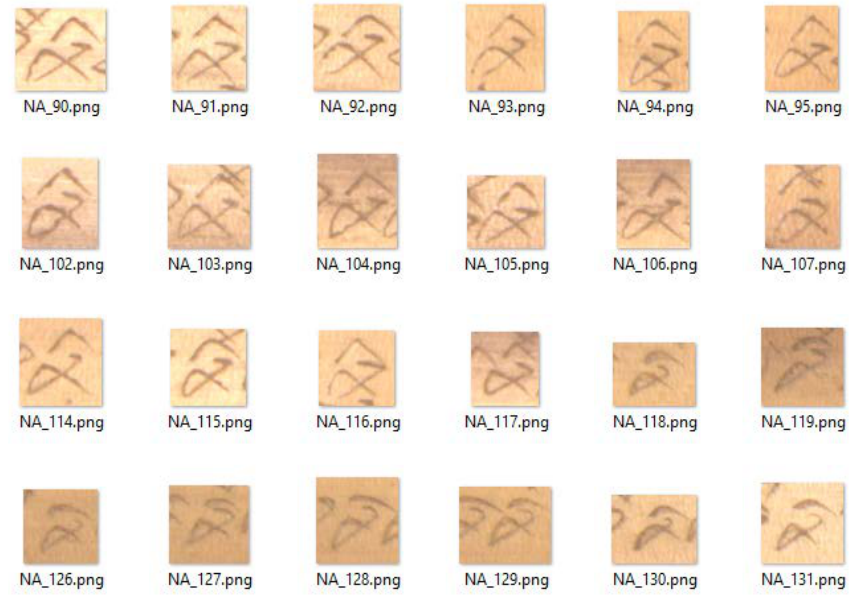
Figure 15. Sundanese character dataset.